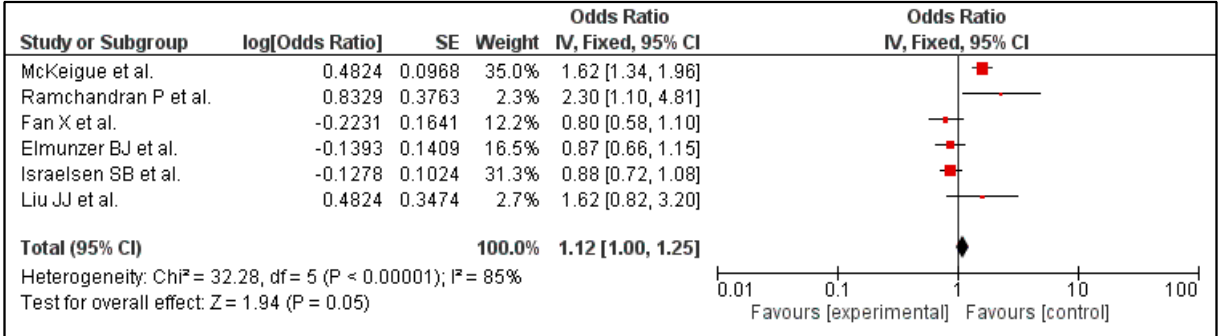
Figure 4. Risk of mortality in patients with COVID-19 on PPI versus not on PPI.